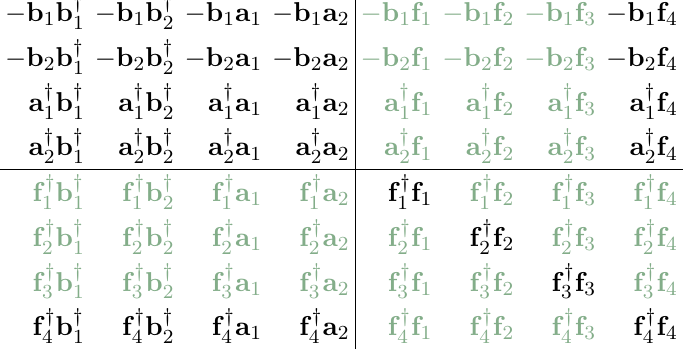
Figure 1 . psu (2 ; 2 j 4) generators. The generators marked in green correspond to broken symmetries in the (cid:12) -deformed